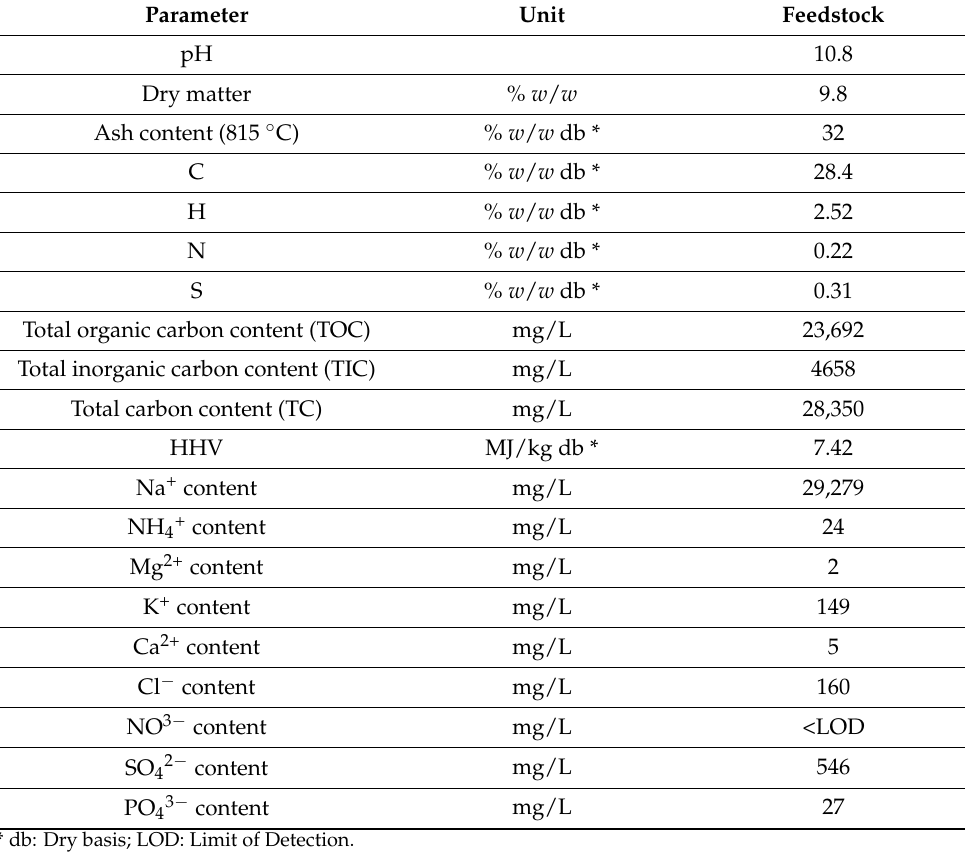
Table 1. Characterization analyses of the feedstock.